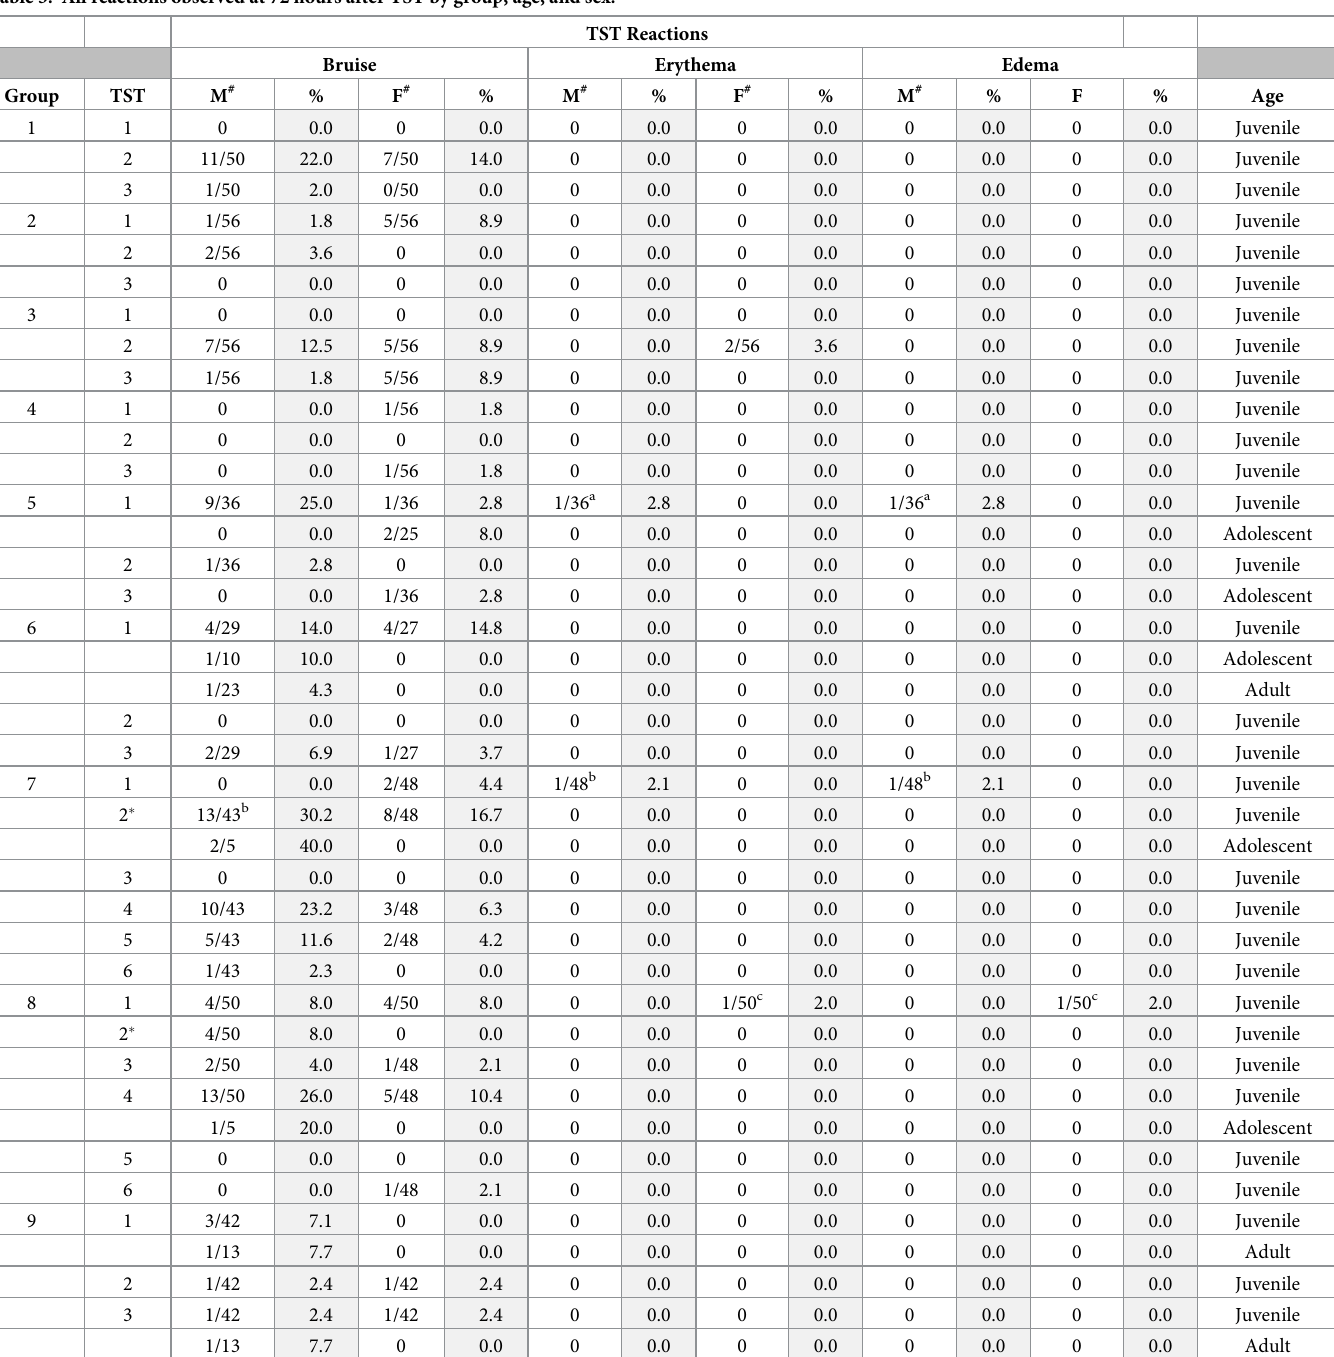
Table 3. All reactions observed at 72 hours after TST by group, age, and